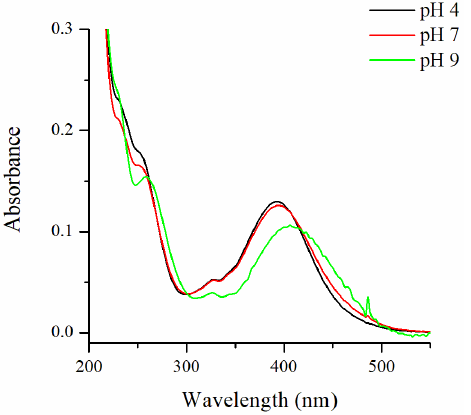
Figure 1. Absorption spectra of probe 3 in aqueous solution at different pHs.